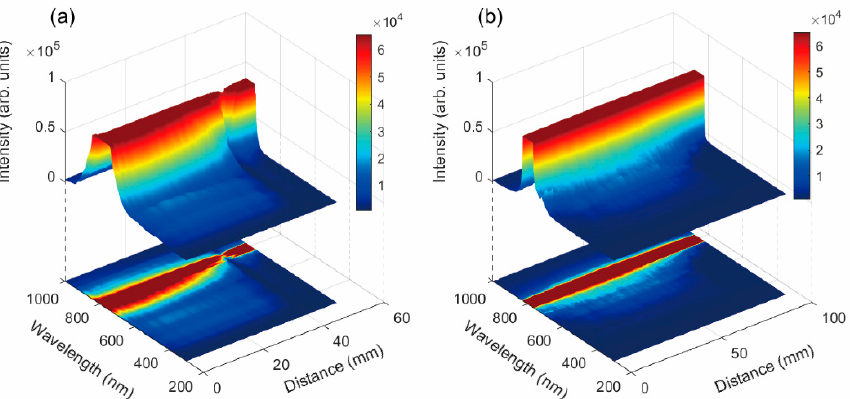
Figure 2. Variation of the SC induced by the filamentation of ( a ) LG and ( b ) BG beams with D in the case of l = 0. The incident pulse energy of LG and BG beams are 104 μ J and 188 μ J, respectively.